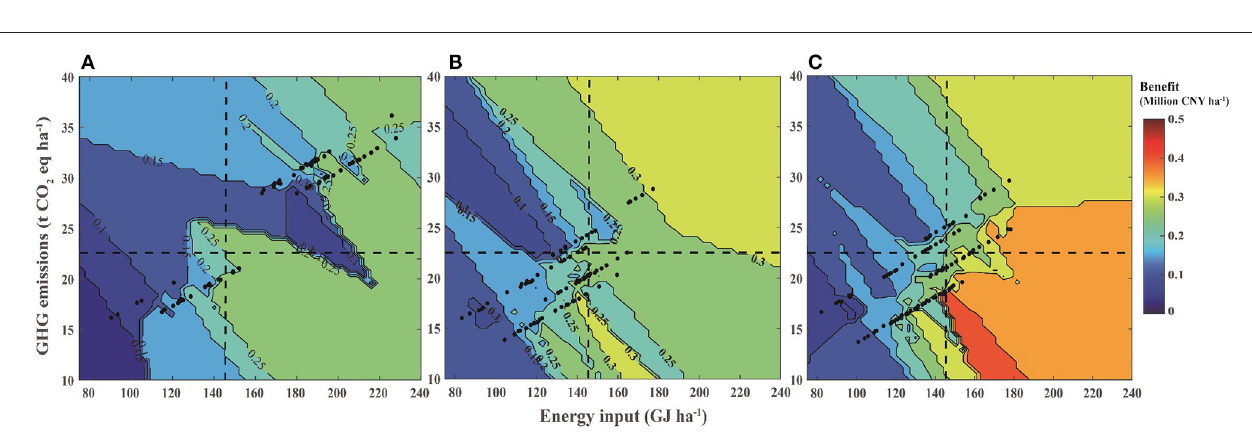
FIGURE 8 | Contour maps of energy inputs, GHG emissions, and economic benefits in different fertilizer treatments. (A–C) represent FP, OPT, and OPT + Mg, respectively. The dotted lines represent the average values of energy input and GHG emissions. The black dots represent the three-dimensional coordinates of the original data points, and the different numbers on the contour lines indicate the economic benefit values.